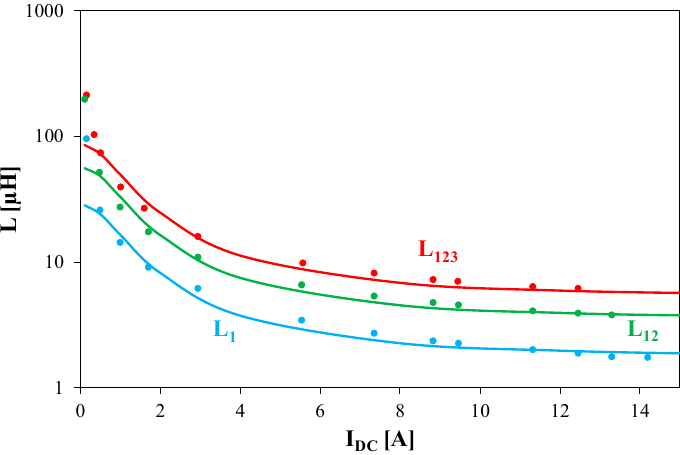
Figure 9. Dependence of inductance L 1 , L 12 , and L 123 on the direct current I DC at f = 200 kHz.